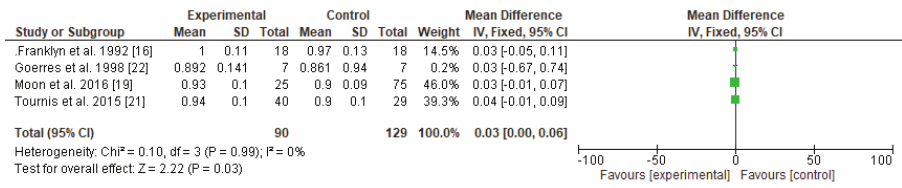
Figure 7 : TSH suppression and bone mineral density among premenopausal women lumbar